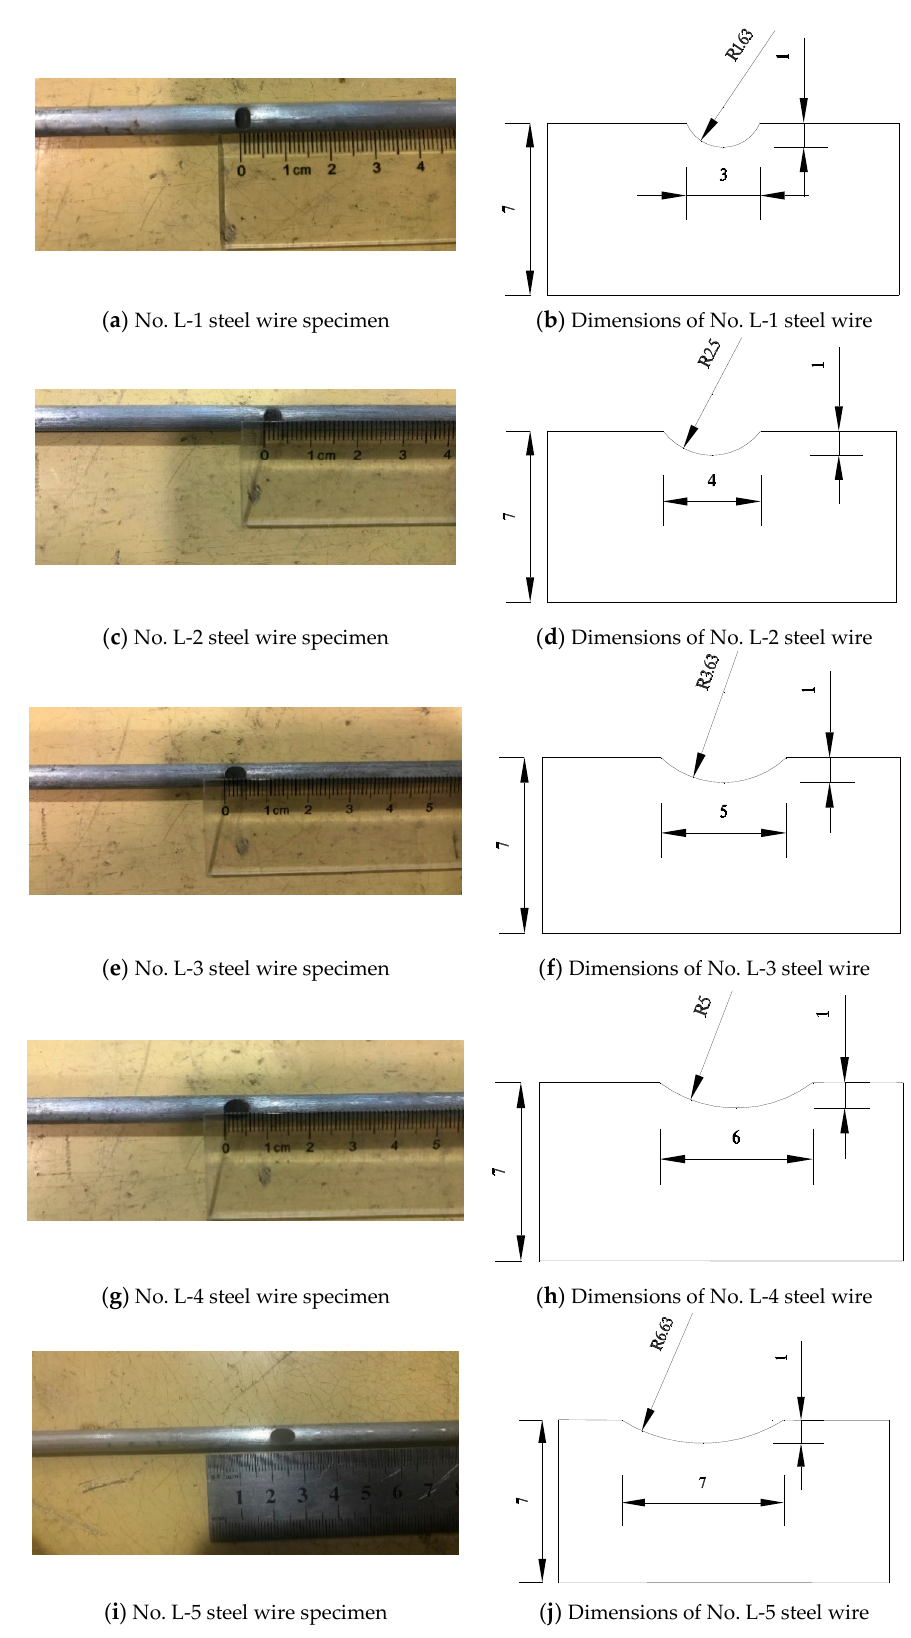
Figure 17. Wire specimens and schematic diagram of steel wire with semi-ellipsoidal notches of di ff erent